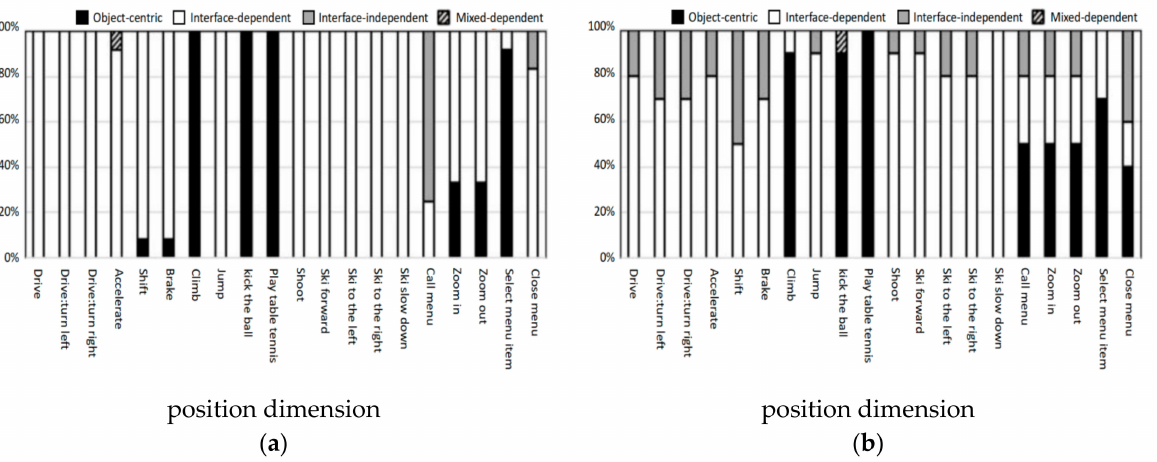
Figure 8. ( a ) Action distribution of young group in the position dimension; ( b ) action distribution of elderly group in the position dimension.